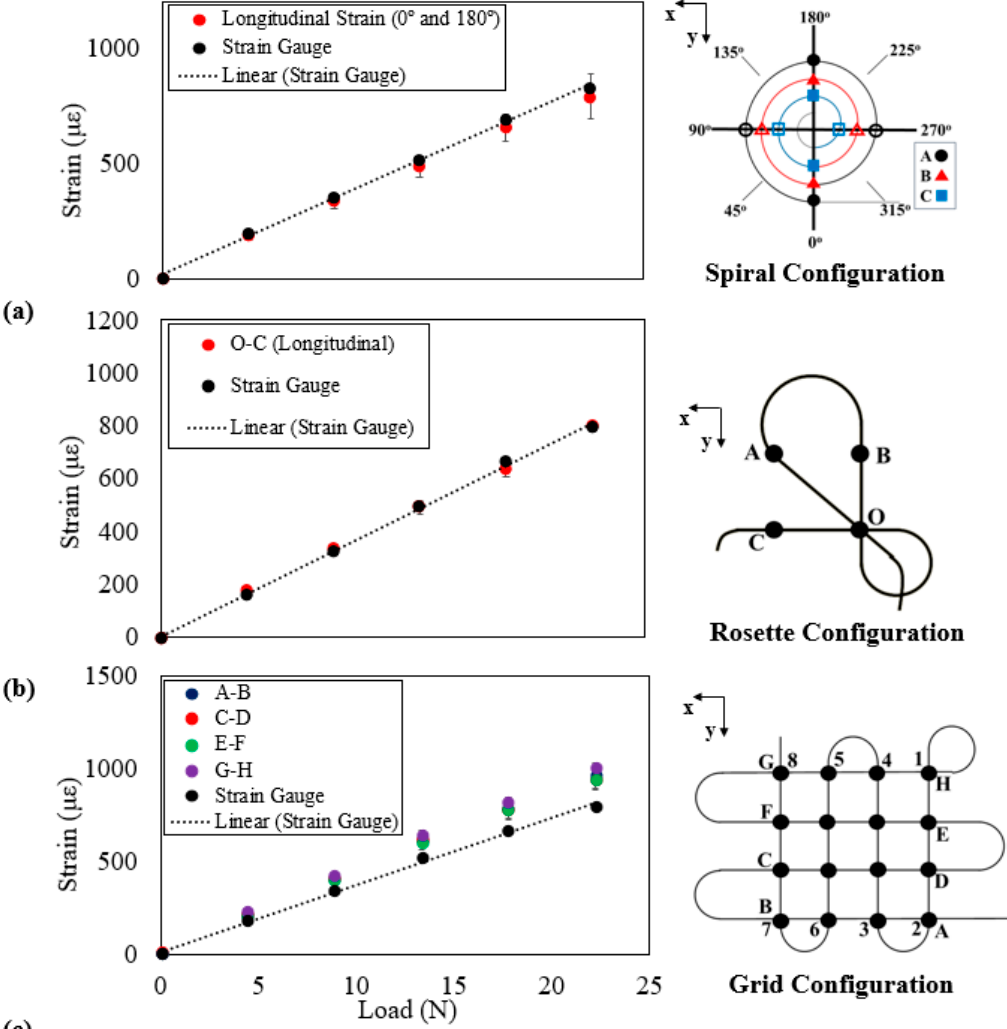
Figure 7. Measured absolute strain from ( a ) spiral, ( b ) rosette, and ( c ) grid configurations compared to the longitudinal strain from the strain gauge. Table 2. Strain values from the optical fiber (OF) sensors and strain gauges (SG). Applied Load